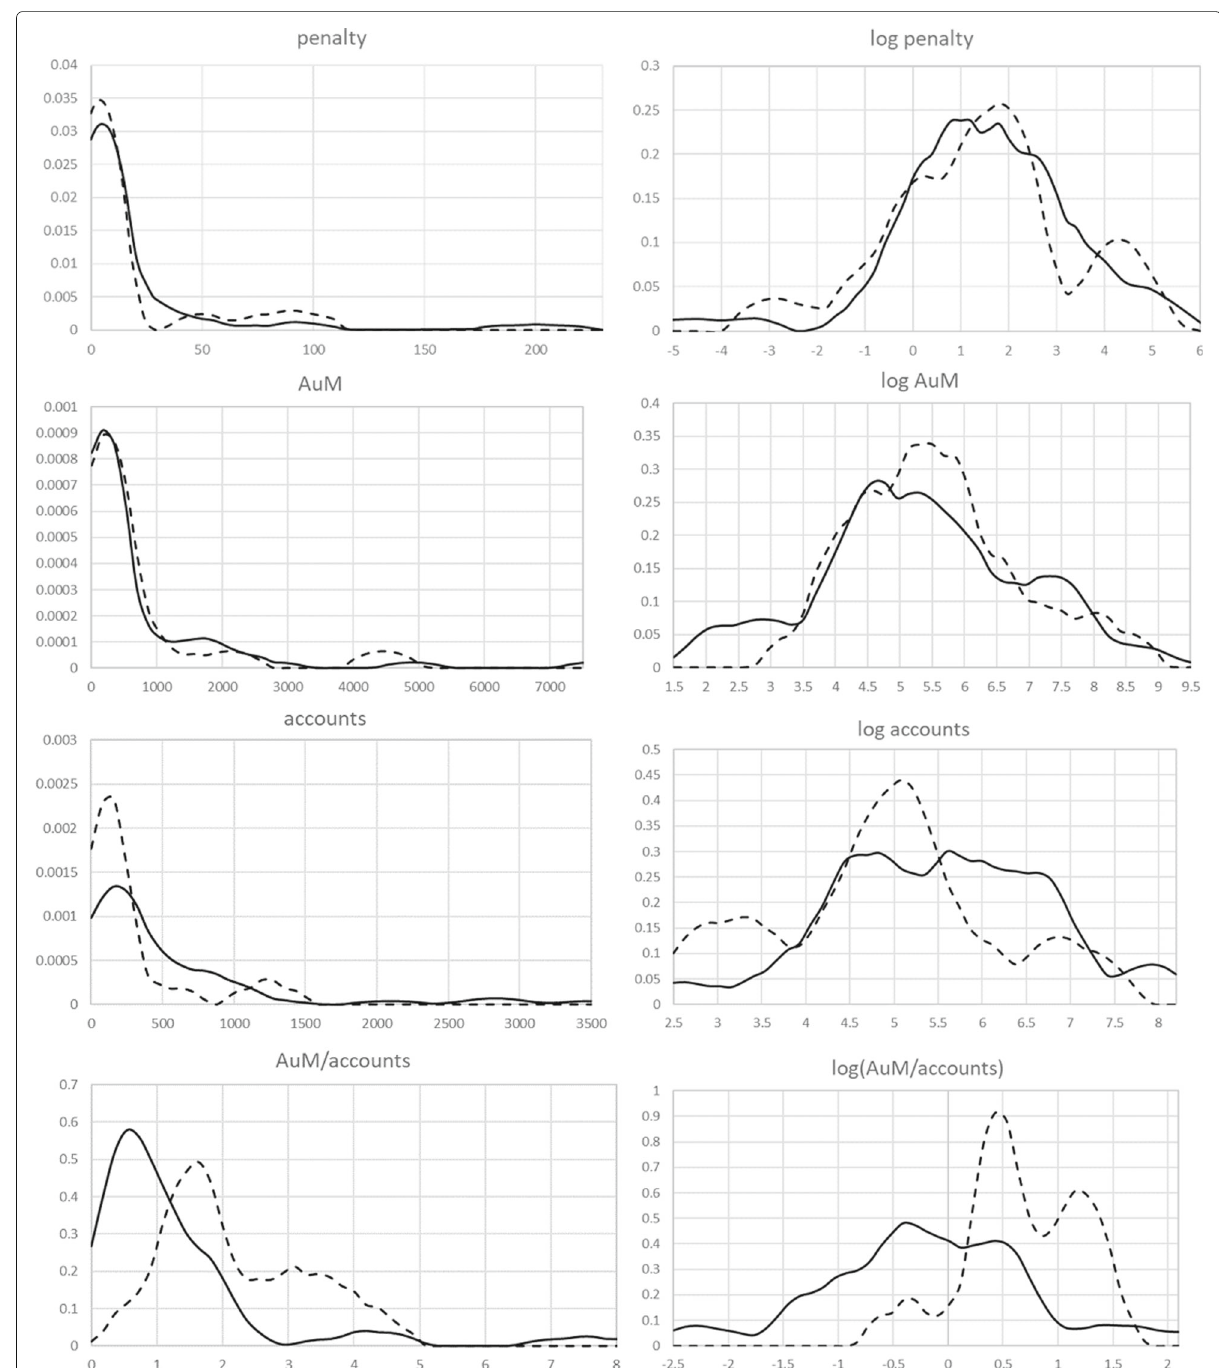
Fig. 1 Distributions (kernels) of some data. The solid lines are for the 60 banks for which we have balance sheet data; the dashed lines are for the 18 banks for which we do